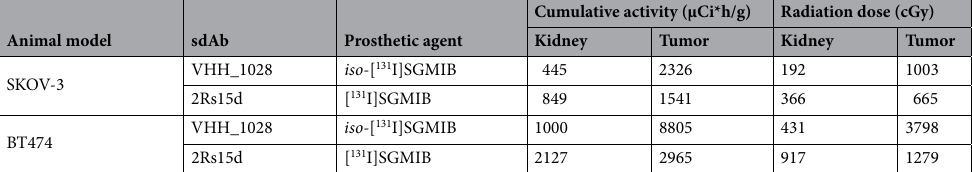
Table 3. Absorbed cumulative radiation dose estimates of [ 131 I]SGMIB-2Rs15d and iso- [ 131 I]SGMIB- VHH_1028 to kidneys and tumors for a hypothetical dose of 37 MBq. Estimates were based on biodistribution data in Tables 1 and 2. Cumulative radioactivity were calculated using the trapezoid integration method by calculating area under the activity/g tissue curves, extrapolating to when negligible activity remained. They were converted to absorbed cumulative dose by multiplying the equilibrium absorbed dose constant for 131 I, 0.4313